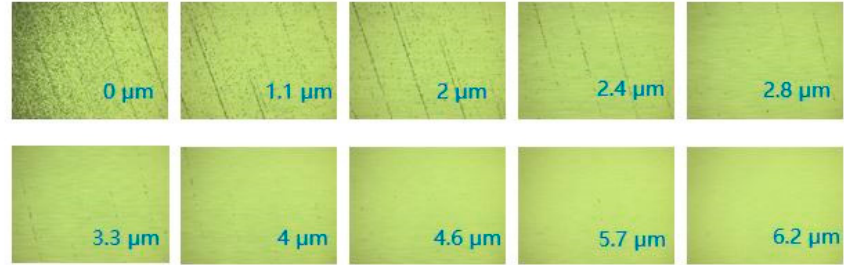
Figure 20. Microscopic images of subsurface cracks at different subsurface depths.